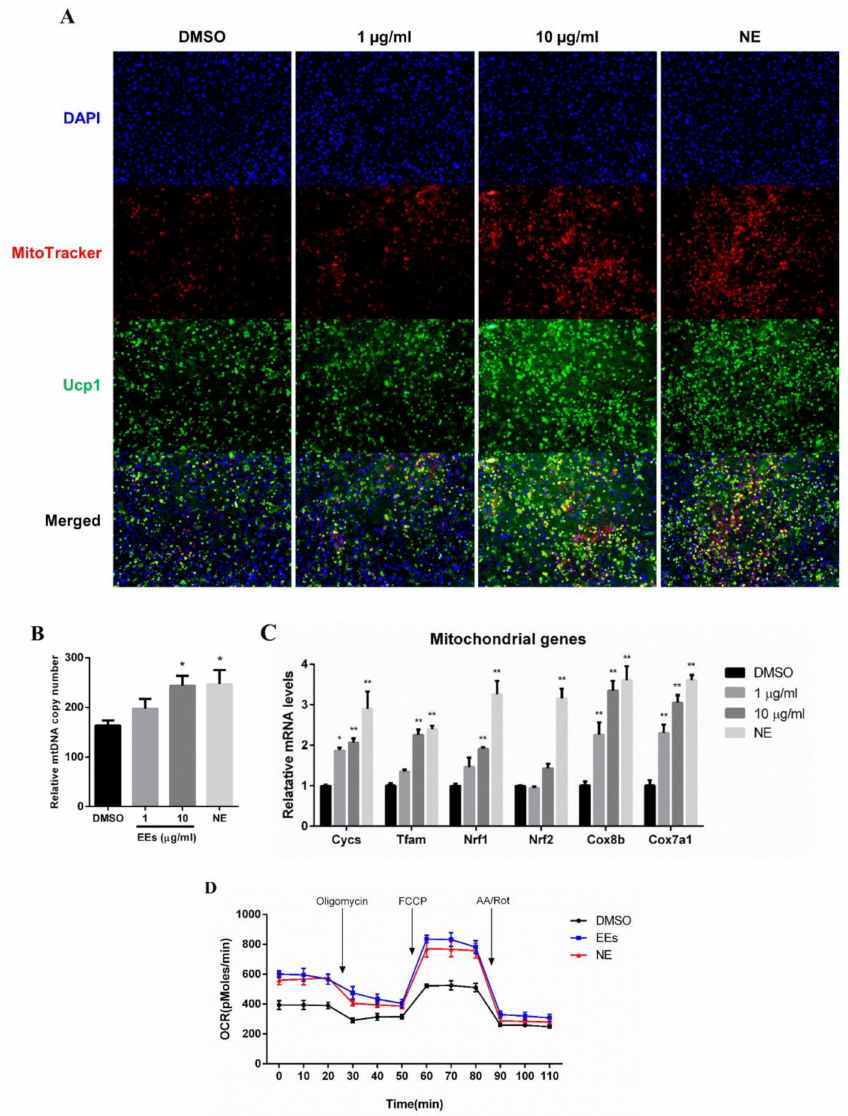
Figure 3. Effects of EEs on mitochondrial biogenesis and activity of differentiated mIPA. ( A ) Fully differentiated mIPA were stained with MitoTracker Red and anti-Ucp1 antibody, respectively. Images were analyzed with a fluorescence microscope. ( B , C ) Relative mtDNA copy number and expression levels of mitochondrial genes were analyzed by real-time qPCR. ( D ) Oxygen consumption rate of differentiated mIPA stimulated with 10 µ g/mL of EEs and NE. Results are shown as mean ± SEM ( n = 3). *, p < 0.05; **, p < 0.01 compared to the untreated control